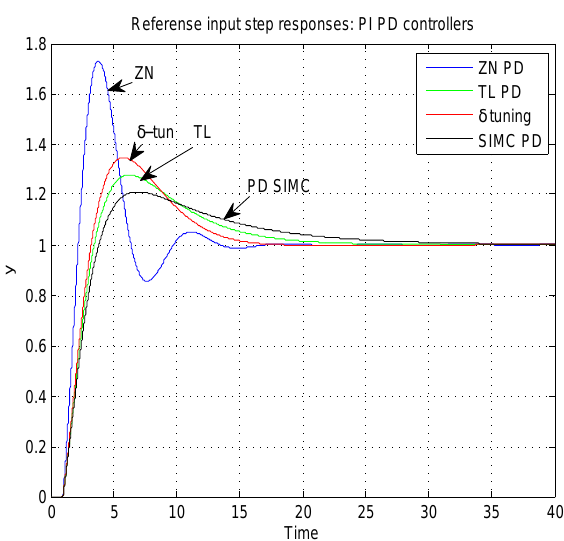
Figure 2: Unit reference step response, no disturbance. PD controllers for a DIPTD plant with K = 1 and τ =